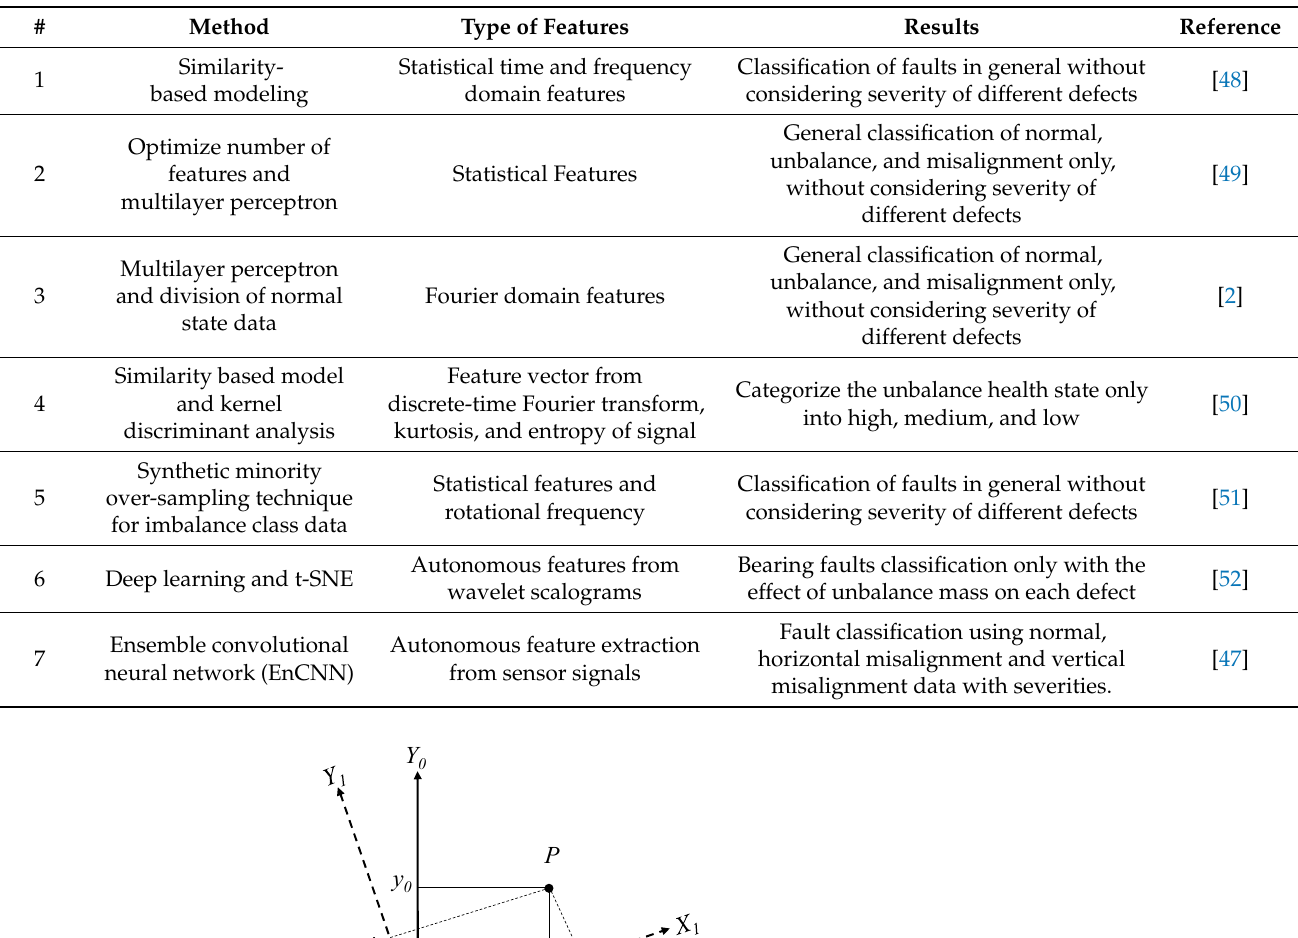
Table 2. Summary of published literature using MafaulDa.